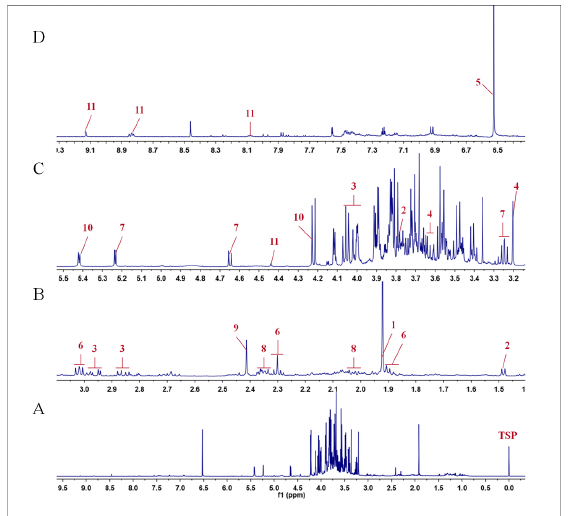
Figure 1. Typical 1 H-NMR spectra of mulberry leaf extracts. ( A ) Full 1 H-NMR spectrum from δ 0.0 to δ 9.5 (TSP- d 4 as an internal standard with chemical shift at δ 0.0); ( B ) Enlarged spectrum from δ 1.0